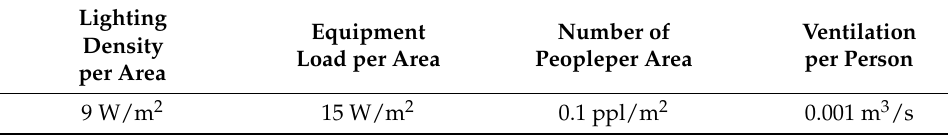
Table 2. Parameter settings of energy consumption